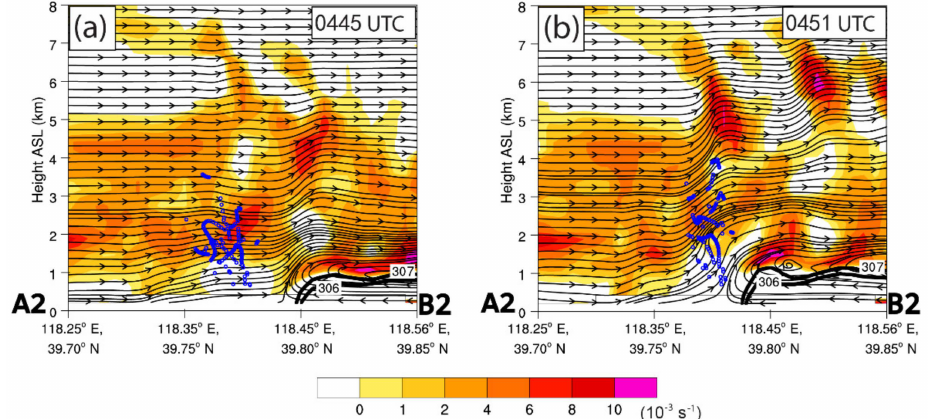
Figure 12. ( a , b ) Vertical cross section of the VSHW (shading, units: 10 − 3 s − 1 ) and streamline along the line segment A2B2 in Figure 10b on 31 July 2010. The small blue circles indicate the location (projected to the vertical cross section) of the air parcels. It also shows the potential temperature (black solid contours at values of 306 and 307 K) that indicates the thermal boundary of the GF. The specific time is shown in the upper right corner of each